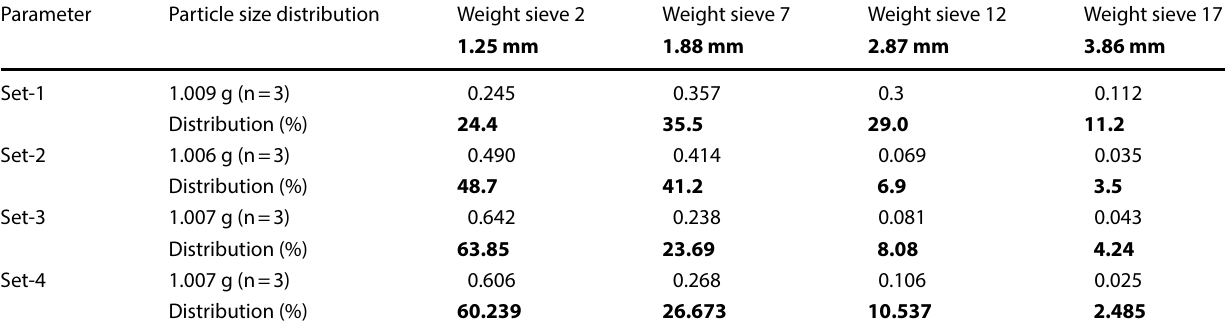
Table 1 Particle size distribution following hemp homogenization as tested for via particle sieves